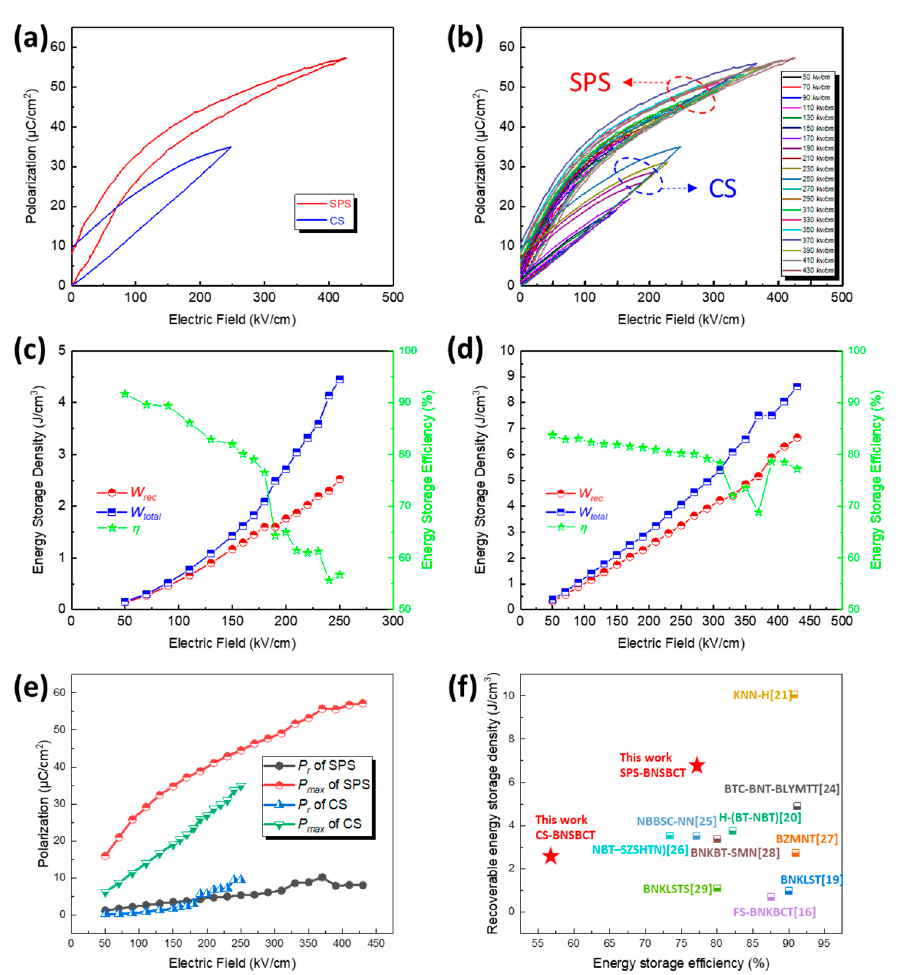
Figure 3. ( a , b ) P-E loops of the BNSBCT ceramics prepared by conventional sintering and SPS at varying electric field; ( c , d ) energy storage properties as a function of electric field for the